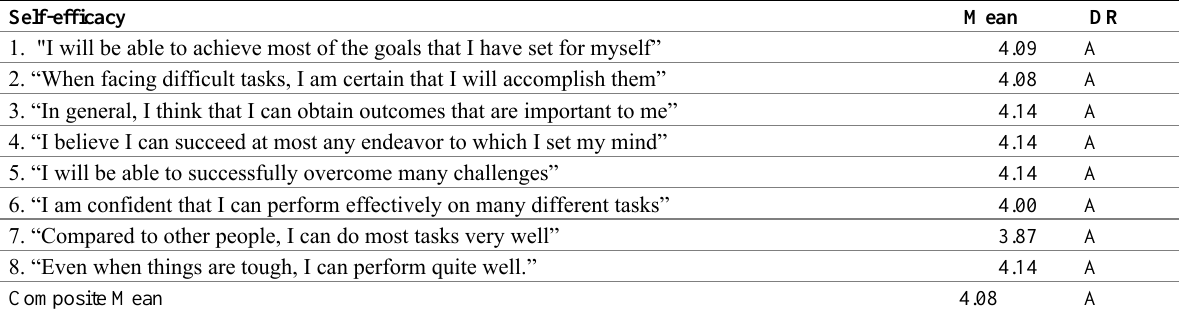
Table 1: Self-efficacy of the employees of Divine Word Colleges in the Ilocos Region